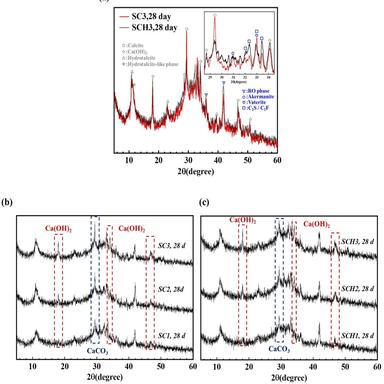
XRD phase composition of mortar with different activators at 28 days: (a) XRD overlapping patterns of SC3 and SCH3; (b) SC1; SC2 and SC3 XRD patterns at 28 days; (c) SCH1, SCH2 and SCH3 XRD patterns at 28 days.